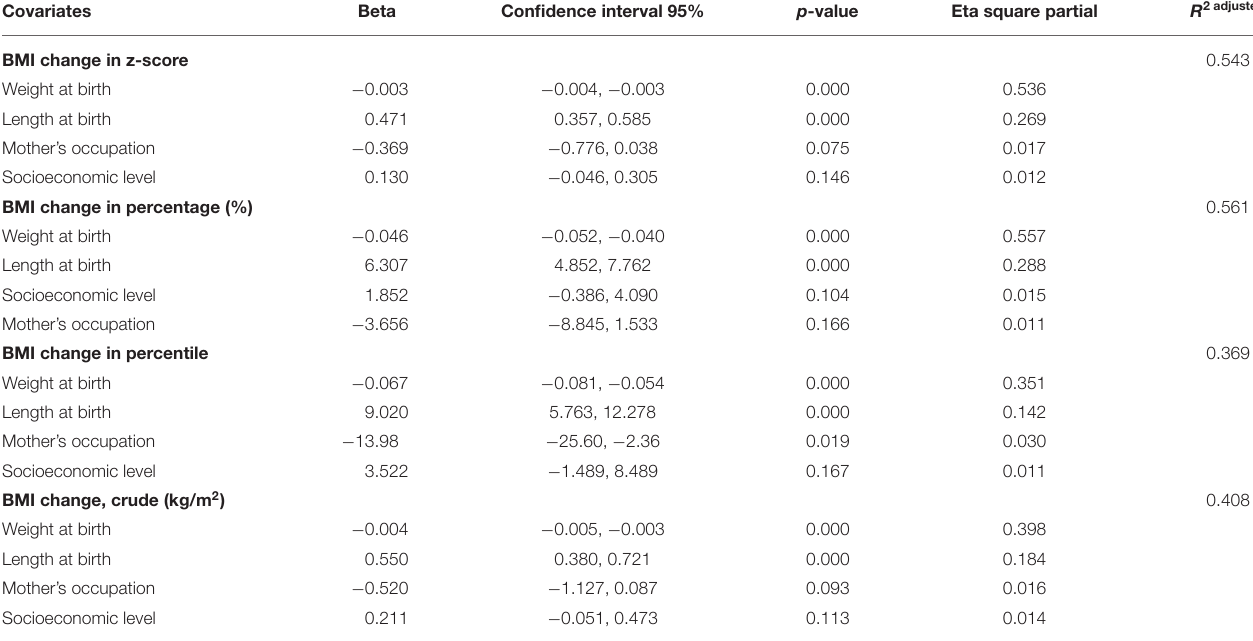
TABLE 6 | Univariate general linear model to determine the predictor variables of BMI change parameters.